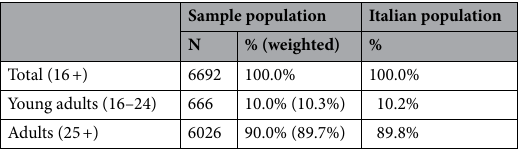
Table 1. Population: sample (weighted and not weighted) vs. Italian